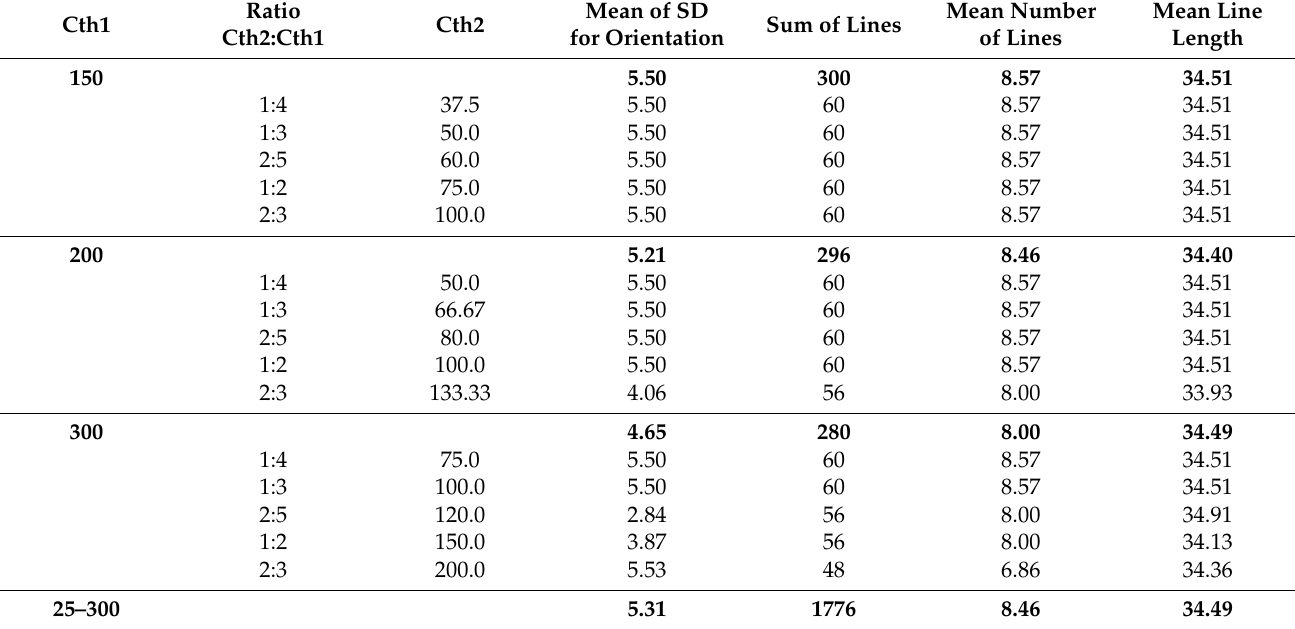
Table 4. Results of FLD for different combinations of Canny Threshold parameters cth1 and cth2; numbers on the bottom line represent the result of all values for